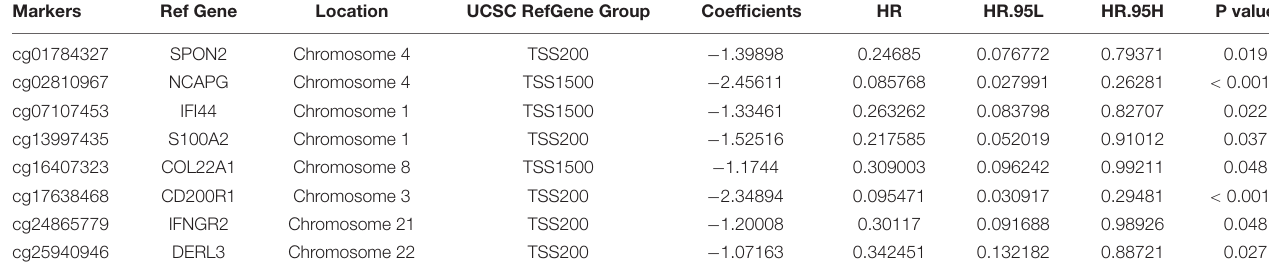
TABLE 1 | The 8 prognosis-associated DNA methylation sites to construct the epigenetic signature. Markers